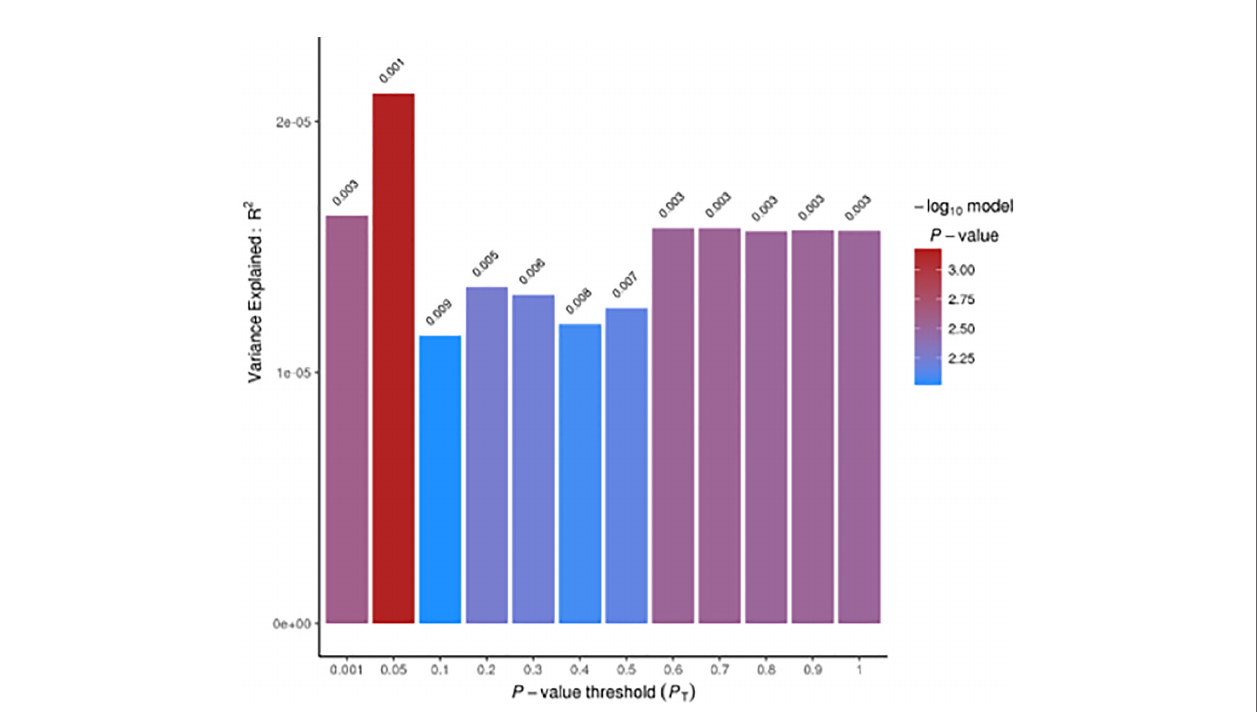
FIGURE 1 | Summary-Summary polygenic risk score (Sum-Sum) analysis between PDW and Parkinson ’ s disease (PD) risk. No direction of effect could be inferred from Sum-Sum analysis, as per PRSice output